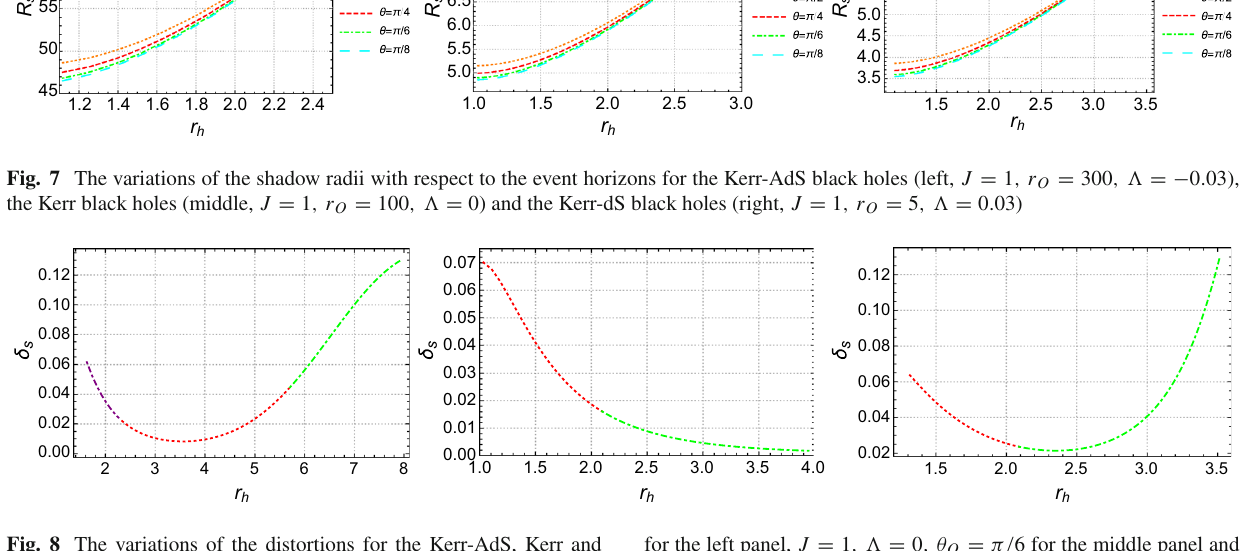
for the left panel, J = 1 , (cid:13) = 0 , θ O = π/ 6 for the middle panel and J = 1 , (cid:13) = 0 . 03 , θ O = π/ 6 for the right